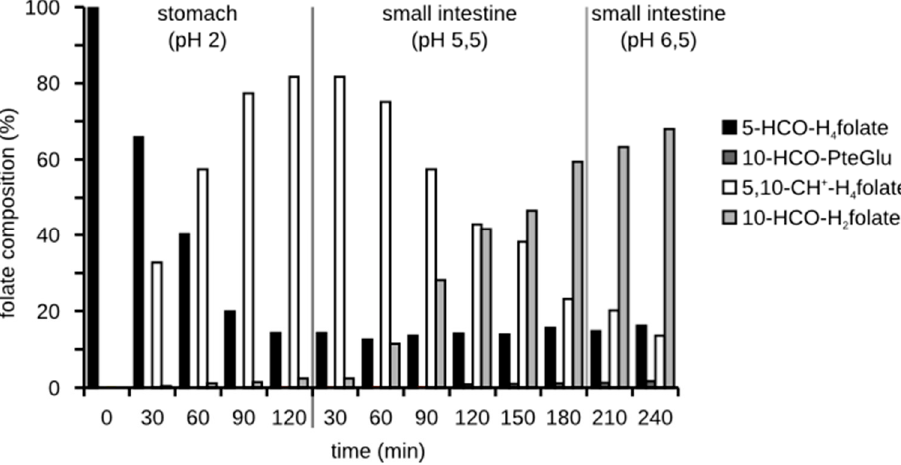
Figure 3. Chronological composition of a 5-HCO-H 4 folate solution during the simulated digestion.